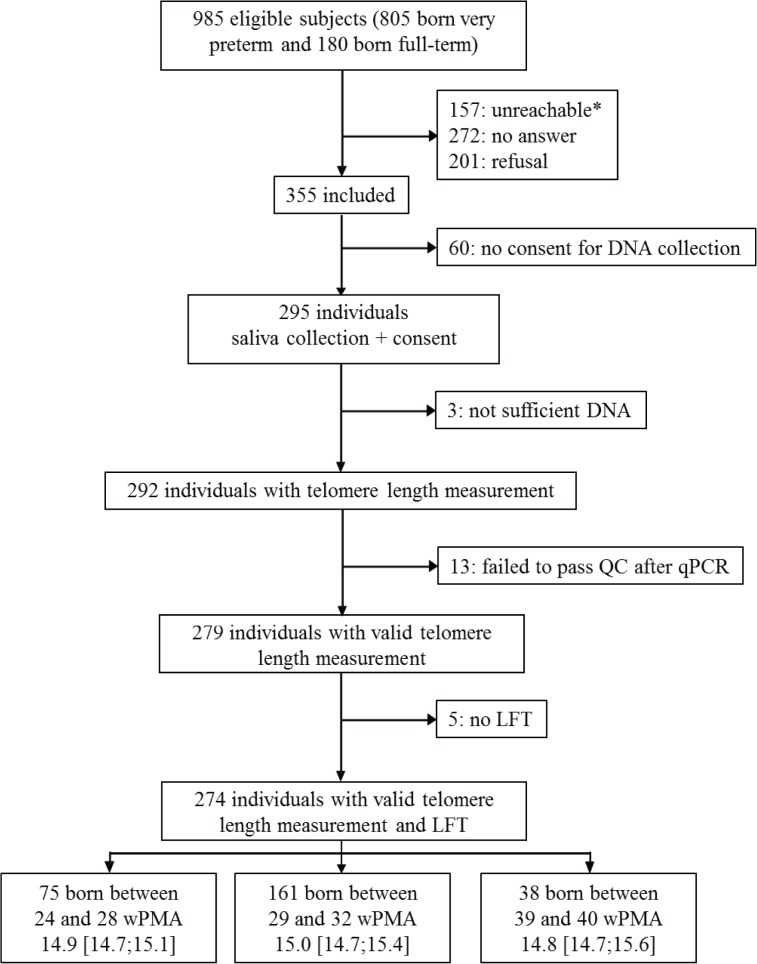
Flowchart of the study population.For each group, age at the time of the study is expressed as medians [IQR]. *probable move without leaving a forwarding address. LFT: lung function tests; QC: quality control; qPCR: quantitative polymerase chain reaction; wPMA: weeks of post-menstrual age.